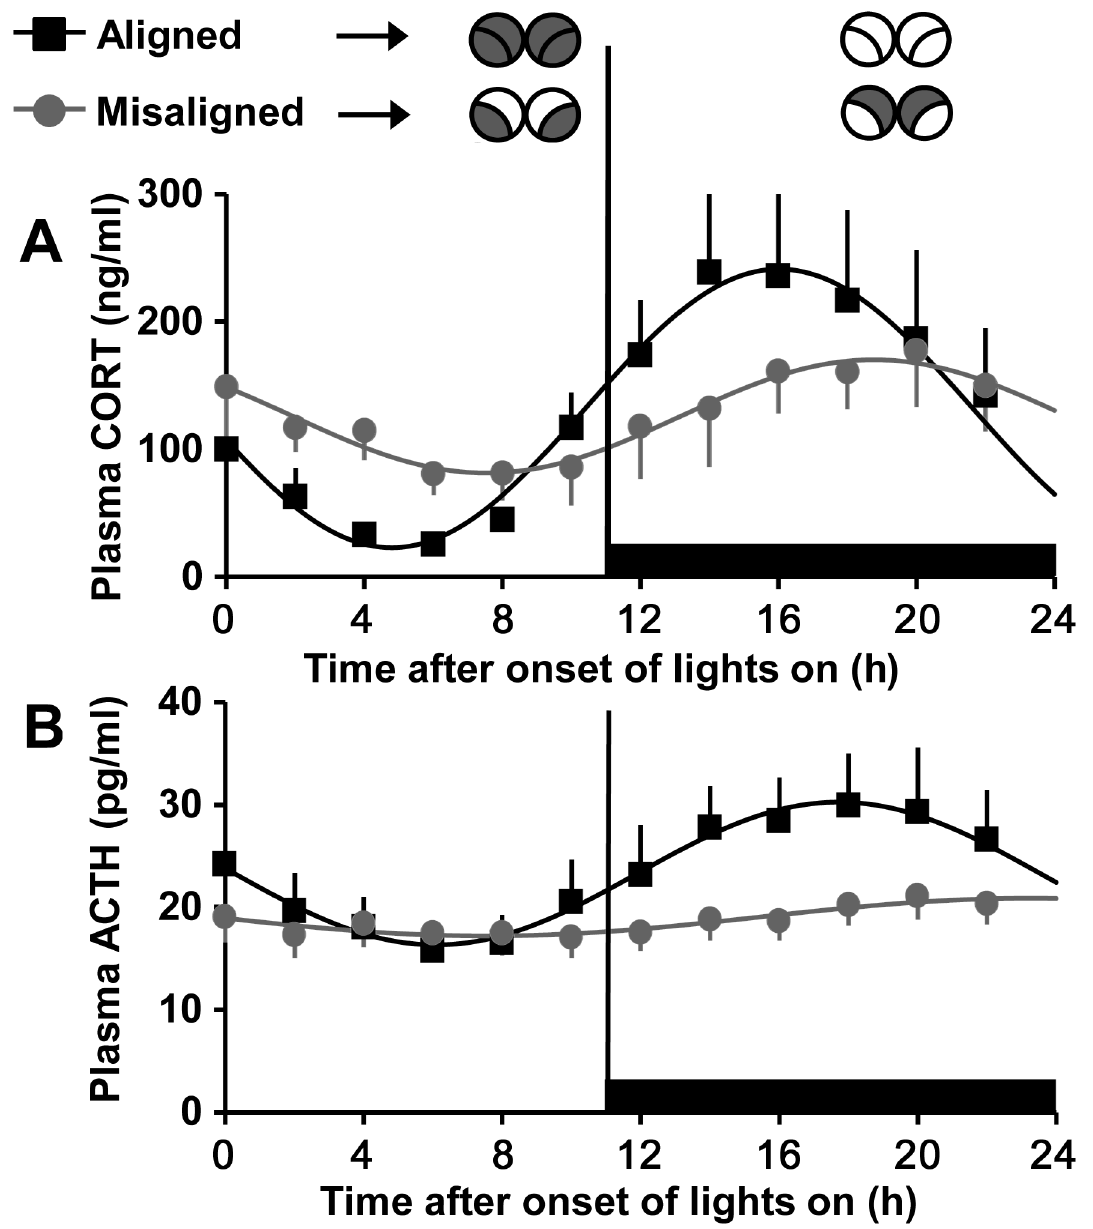
Figure 3. Plasma corticosterone and ACTH rhythms are disrupted in Sham-operated forced desynchronized rats. Plasma corticosterone (A) and ACTH (B) in Sham treated rats on aligned ( black ) and misaligned ( grey ) days. Black horizontal bars denote times when lights are off. Illustrations ( top ) show predicted Per1 expression patterns, as in Figure 2. Data are means ± SEM and fitted with a sine wave function (see materials and methods). n= 6